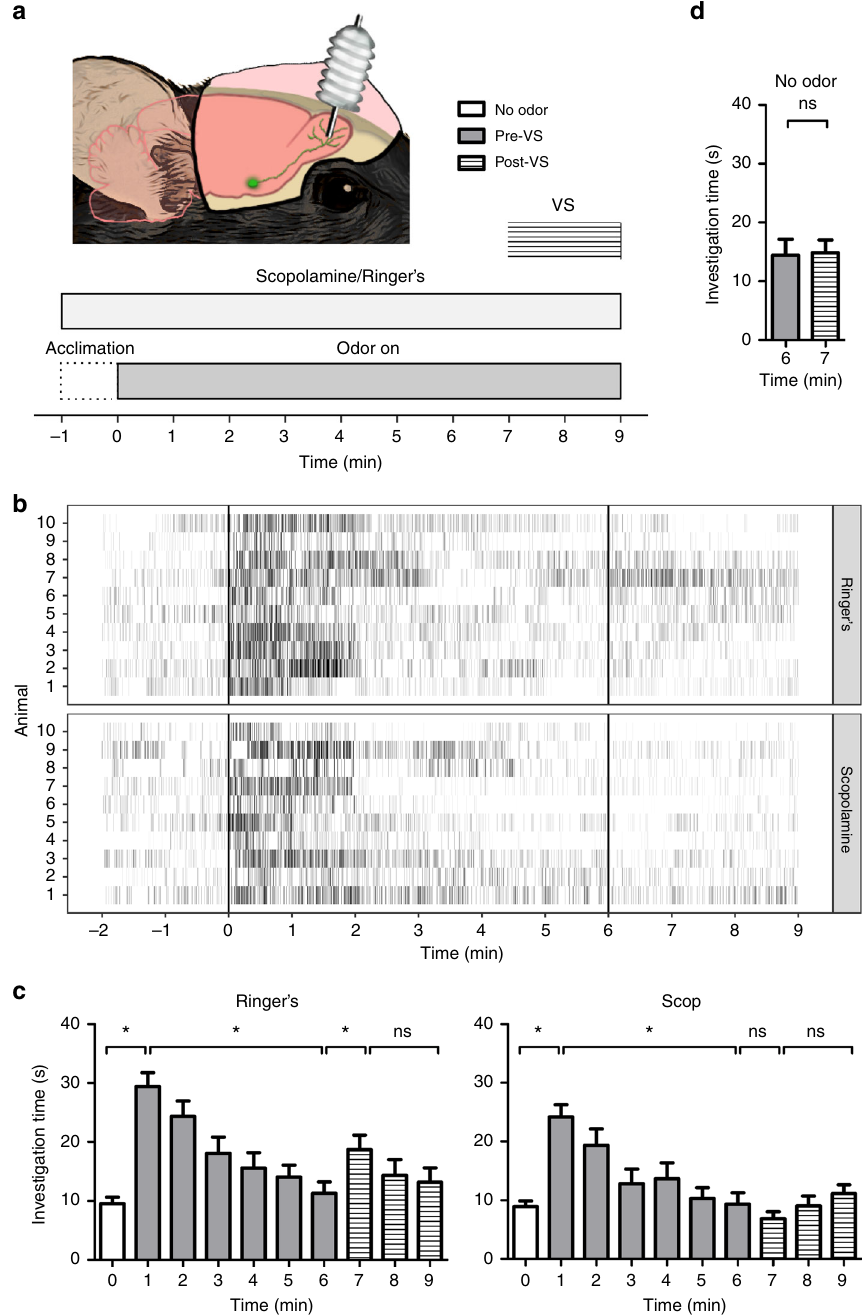
Fig. 5 A visual context change (VS) dishabituates odor investigation behavior. a Schematic illustration of the VS experiment. b Investigation time (seconds ± s.e.m.) after the VS does not increase if odor is not present ( n = 5 mice). c Raster plots of the odor investigation behavior following olfactory bulb (OB) cannula infusion of vehicle (Ringer ’ s) or the cholinergic antagonist scopolamine ( n = 10 mice). d Investigation time after the VS increases when mice receive an OB cannula infusion of Ringer ’ s solution, but does not increase when the mice receive scopolamine. Illustration by Ogg,